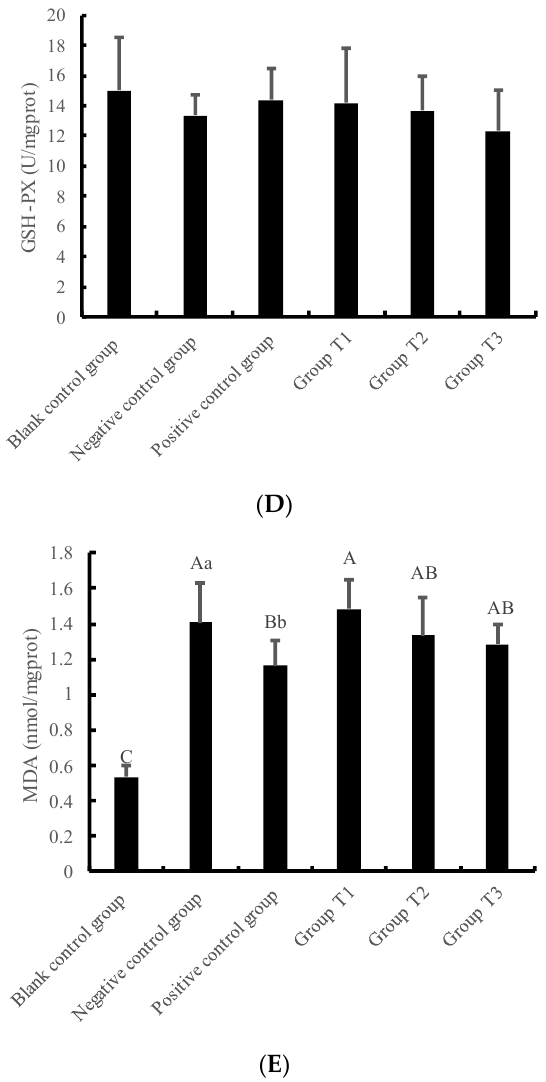
Figure 4. The effects of crude extracts of Dioscorea alata L. on antioxidant function of IPEC-J2 cells pre-protected against damage caused by H 2 O 2 . Cellular antioxidant capacity is mainly reflected by the following indicators: ( A ) T-AOC, ( B ) CAT activity, ( C ) T-SOD activity, ( D ) GSH-PX activity, ( E ) MDA content. Note: Compared with the blank control group, the difference was significant for different lowercase letters ( p < 0.05), the difference was extremely significant for different uppercase letters ( p < 0.01), and the difference was not significant for no letters or the same letter shoulder label ( p > 0.05). Blank control group: only DEME high glucose medium; Negative control group: DEME high glucose medium +120 μmol/L H 2 O 2 ; Positive control group: DEME high glucose medium +120 μmol/L H 2 O 2 + 50 μg/mL VC; Group T1-3: DEME high glucose medium +120 μmol/L H 2 O 2 + crude extracts of